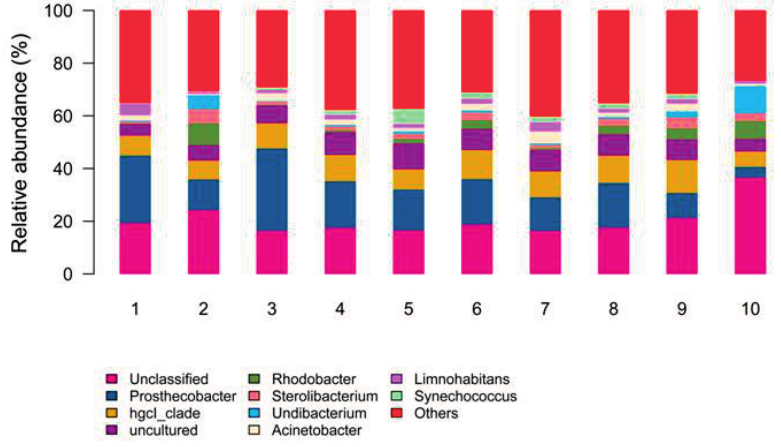
Figure 3. The abundance of dominated bacterial genus in different water layer. 1, 2, 3, 4, 5, 6, 7, 8, 9, and 10 represent 0.5, 5, 10, 20, 25, 30, 45, 50, 55, and 65 m depths,